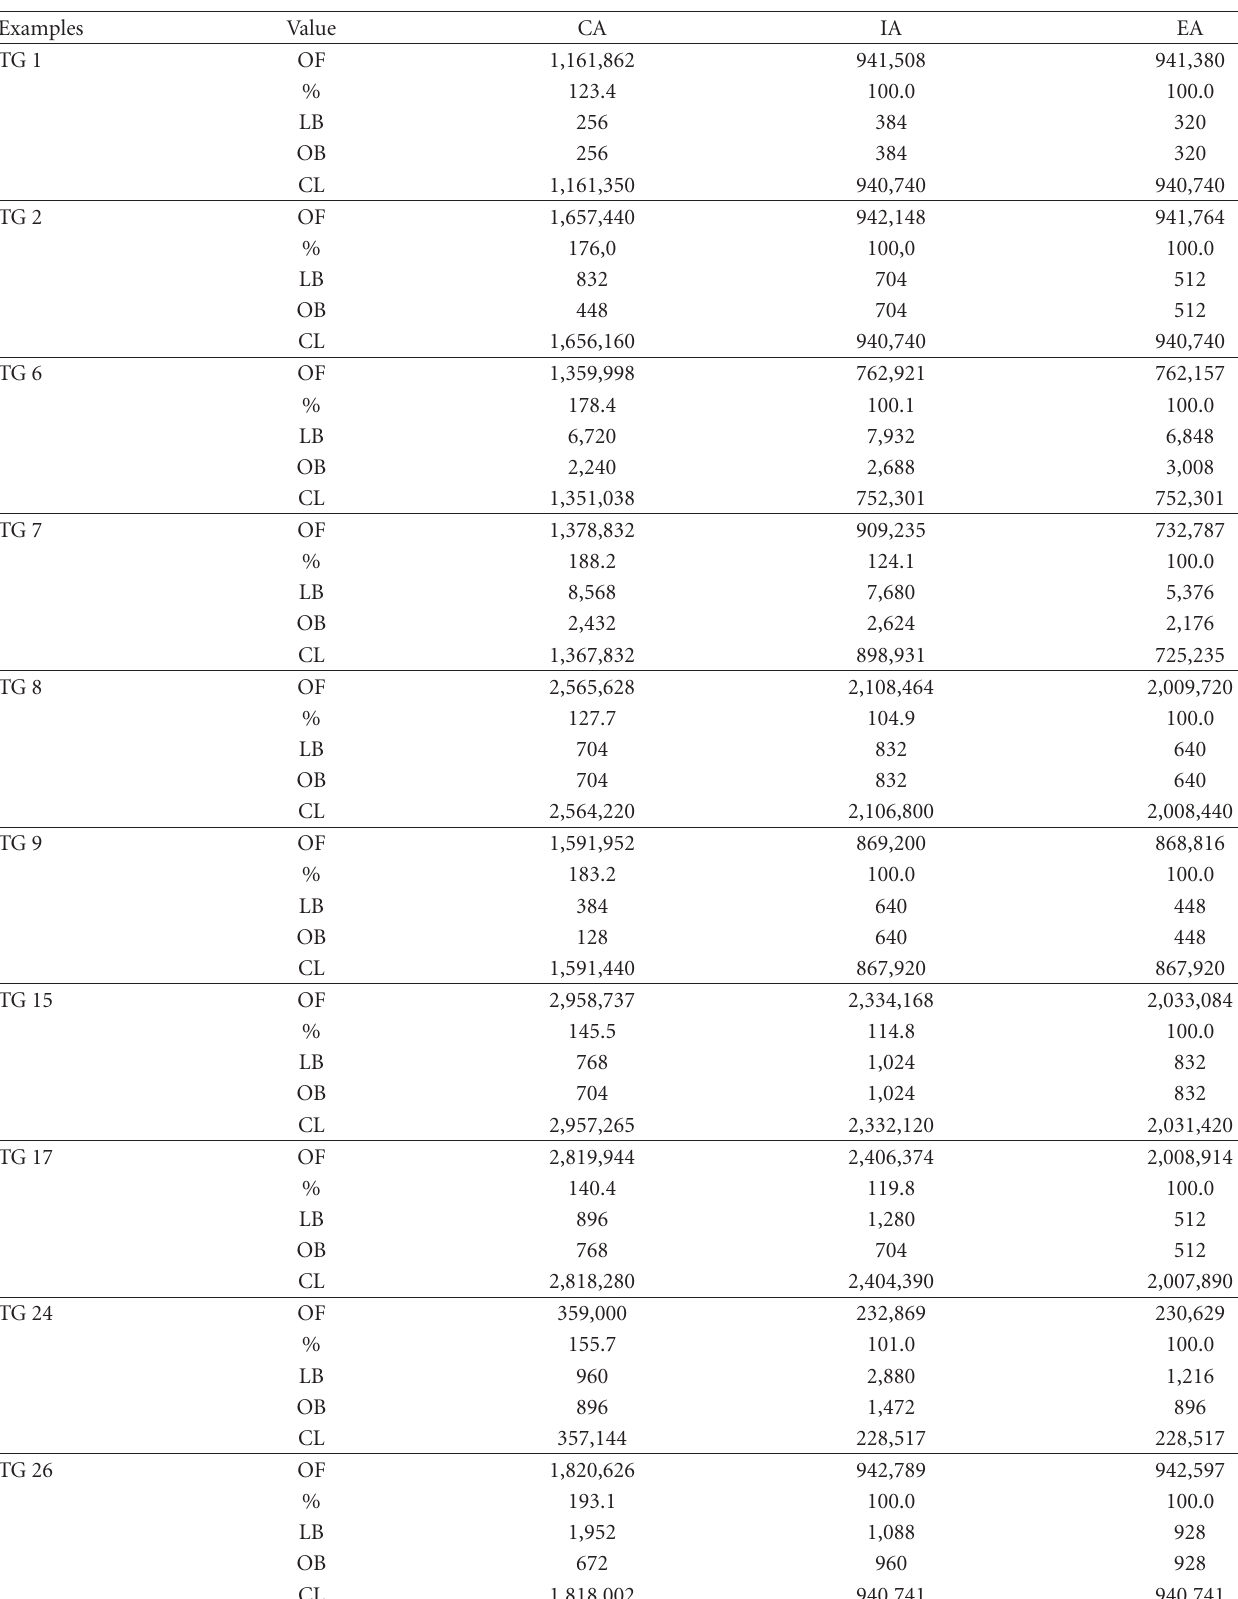
Table 4: Evaluation results for the task graph (TG) examples for α = β = γ = 1 in (5) for constructive algorithm (CA), improvement algorithm (IA), and exact algorithm